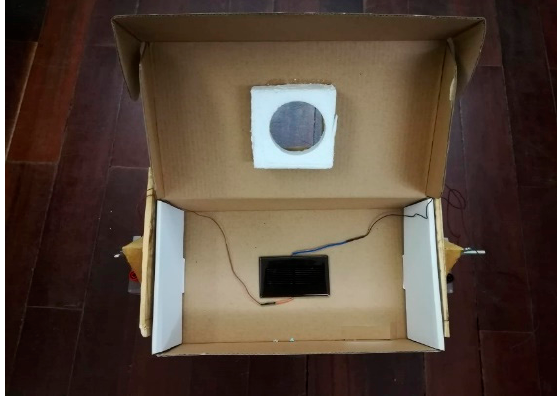
Figure 3. Open structure, with m-Si cell.